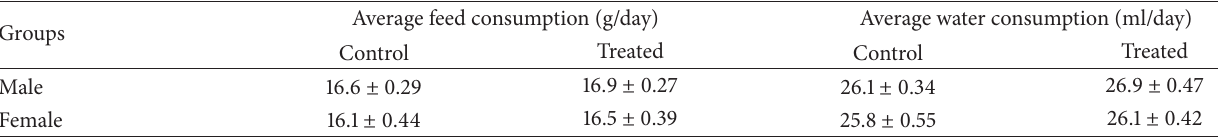
Table 1: Average feed and water consumption of rats.